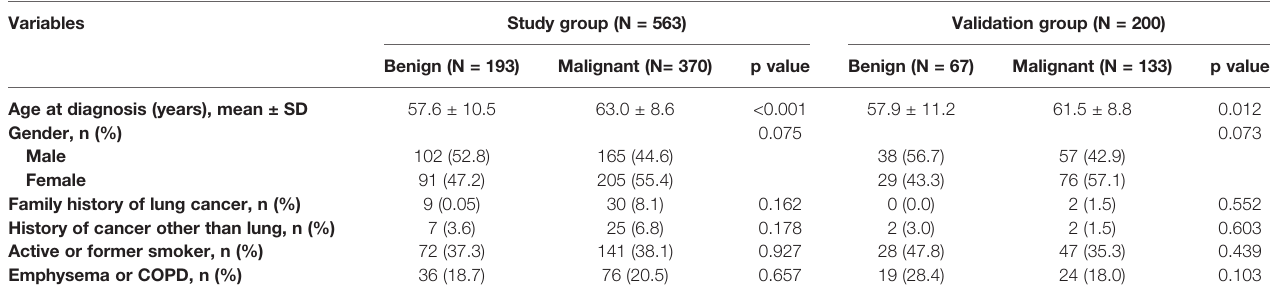
TABLE 1 | Demographic characteristics according to lung cancer status in the study and validation datasets.